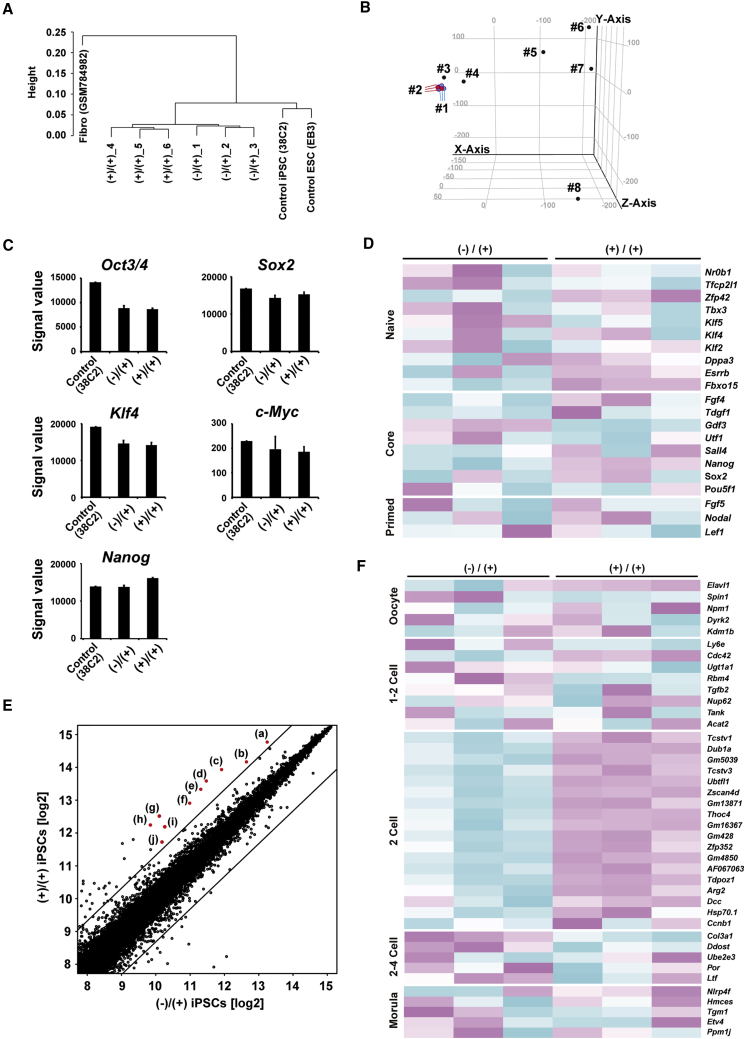
The Differences in Global Gene Expression between (−)/(+) and (+)/(+) iPSCs(A) Hierarchical cluster analysis based on global gene expression of indicated samples. Microarray data of this study and our previous study (GEO: GSE31725) were collectively normalized using the MAS 5.0 algorithm in every analysis.(B) Principal-component analysis of gene expression data. Samples are as follows: nos. 1 and 3, clones of the (−)/(+) iPSCs; nos. 2 and 3, clones of the (+)/(+) iPSCs; no. 3, the clone of the ESCs; no. 4, the clone of conventional iPSC derived from a Nanog-GFP mouse; no. 5, the clone of the ESC-derived neurospheres; no. 6, the clone of the iPSC-derived neurospheres; no. 7, the clone of the E14 embryo ganglionic eminence-derived neurospheres; no. 8, the clone of the fibroblasts. Gene expression data for nos. 3–8 clones obtained in our previous study (GEO: GSE31725) were used for comparison.(C) Expression of pluripotent markers. Signal intensities were determined by microarray analysis (n = 3).(D) Heatmap showing the expression levels for genes that are associated with naive, core, and primed pluripotency.(E) Scatterplots comparing global gene expression patterns between (−)/(+) and (+)/(+) iPSCs. Highly expressed 2-cell embryo- or Zscan4-related genes are shown as red dots. (a) Zscan4, (b) Eif1a/Eif1a-like, (c) Gm13040, (d) AF067061, (e) Dub1, (f) Gm8300, (g) LOC639910 Gm13871, (h) Tcstv1, (i) Gm428, (j) Gm18371, and (k) Gm428.(F) Heatmap showing the expression levels of genes that are specifically expressed in early embryonic stages.Error bars represent mean ± SD from three independent experiments (n = 3).